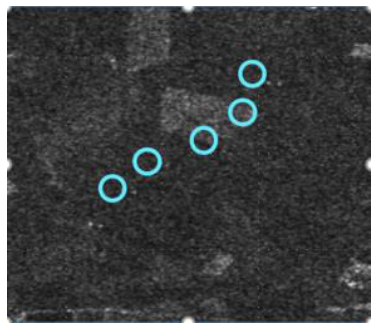
Figure 15 . Ground truth spots of windmills on a